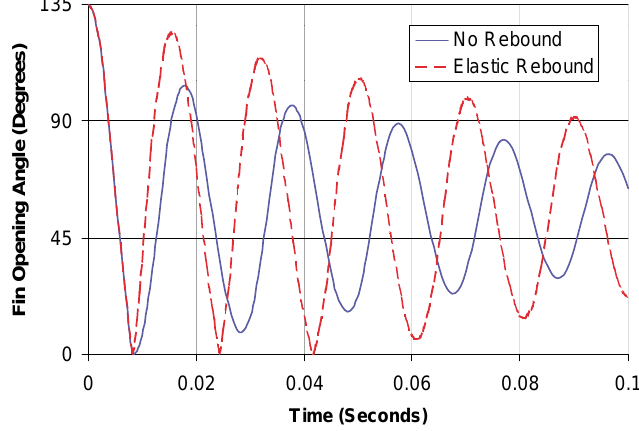
Fig. 14. Fin opening angle as a function of time, no locking mechanism, zero yaw, 15.6 Hz spin rate.